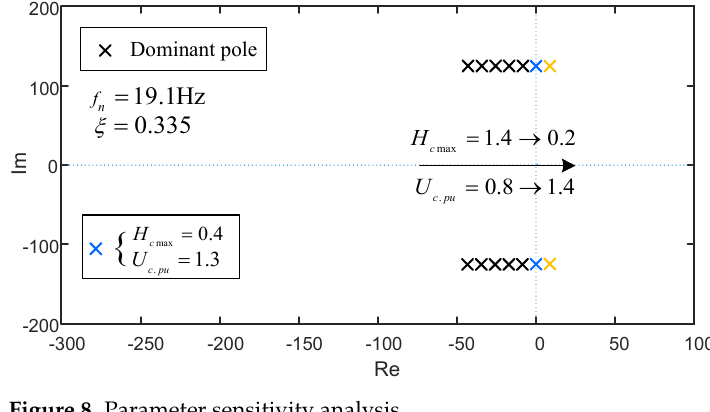
Figure 8. Parameter sensitivity analysis.